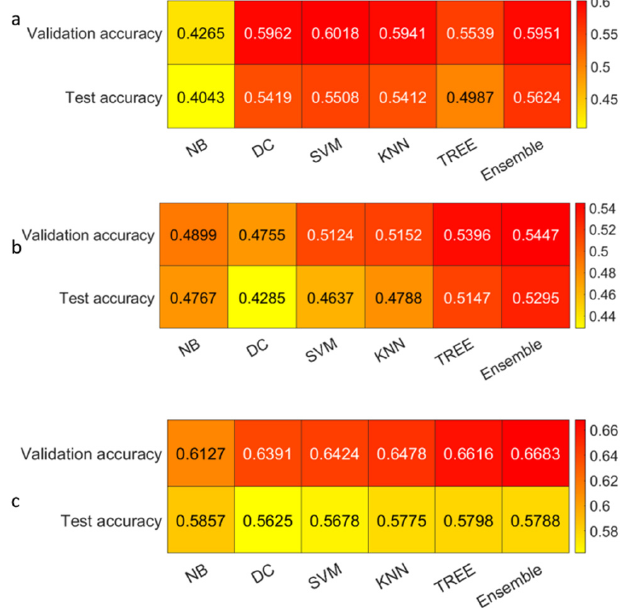
Figure 12. Accuracy heatmaps for the harmonized datasets: ( a ) The 4-classes datasets, ( b ) 3-classes datasets, and ( c ) 2-classes datasets.